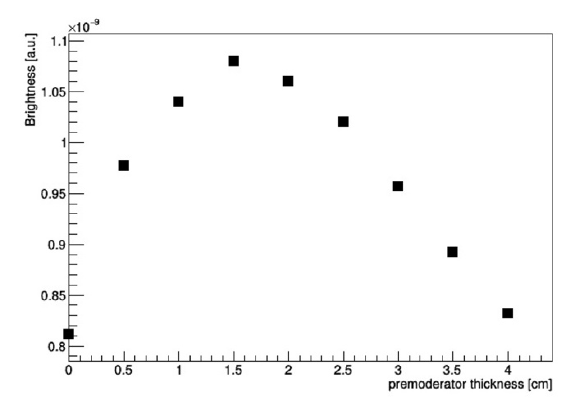
Fig. 7. Effect of premoderator thickness on the source cold brightness.